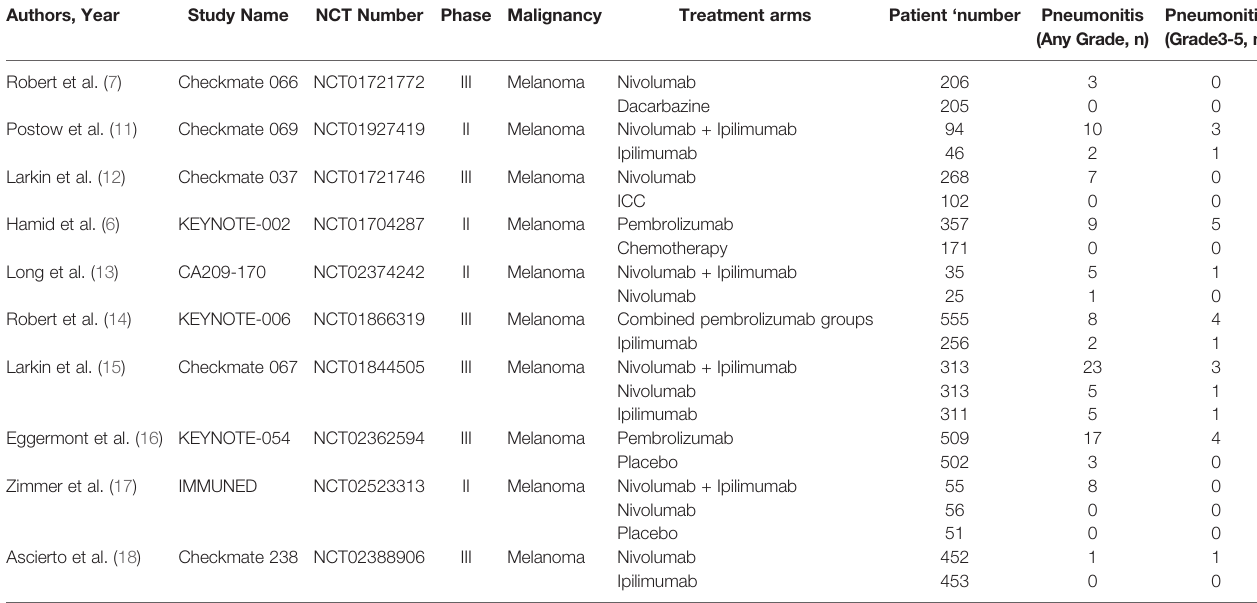
TABLE 1 | Characteristics of included studies.